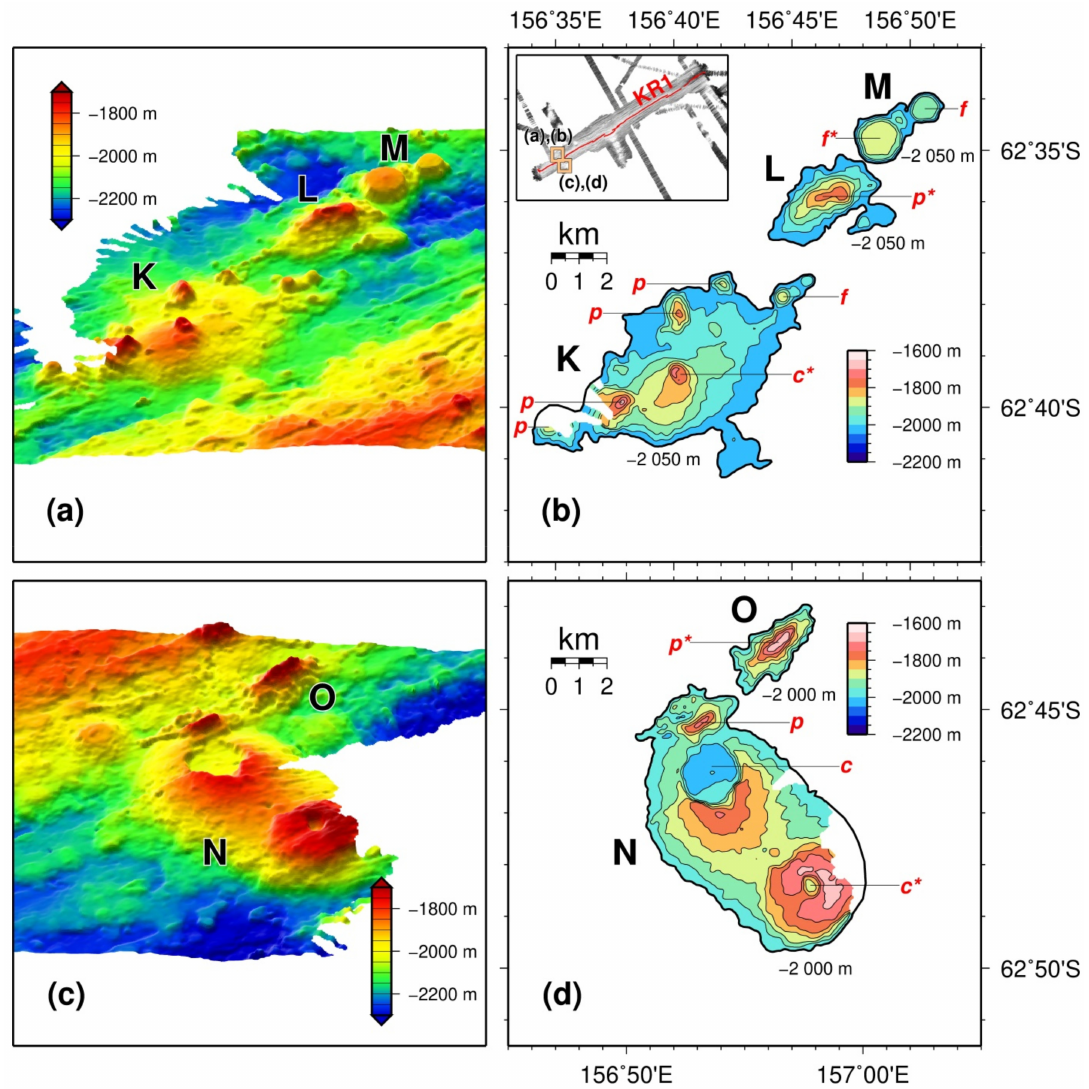
Figure 5. ( a ) Small seamounts and the seafloor, located on the northern flank of western KR1; ( b ) detailed morphology and distribution of seamounts K, L, and M from the reference depth (i.e., 2050 m for all); ( c ) the detected seafloor with small mounds on the southern flank of western KR1; ( d ) the morphology of seamounts N and O from the reference depth (i.e., 2000 m for both). The contour interval of bathymetry is 50 m. The letters with asterisks indicate the representative summit for each